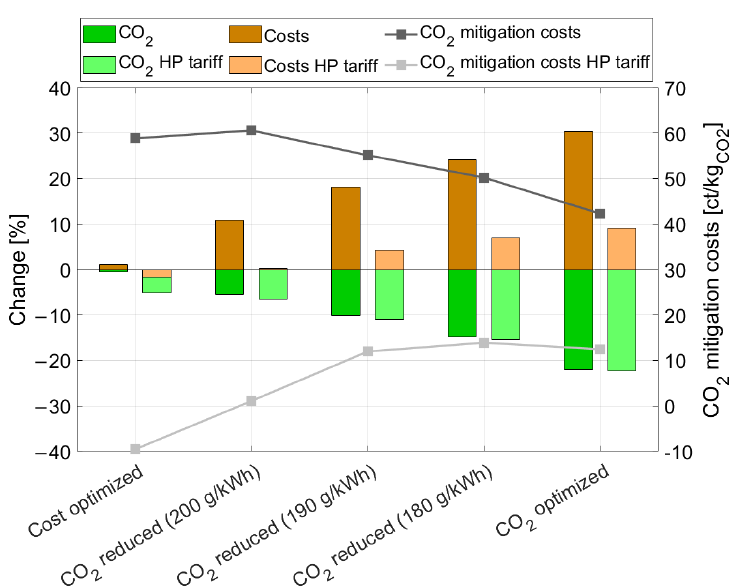
Figure 25. Changes of CO 2 emissions and operation costs with respective CO 2 mitigation costs of different operation strategies compared to a boiler system for household and heat pump